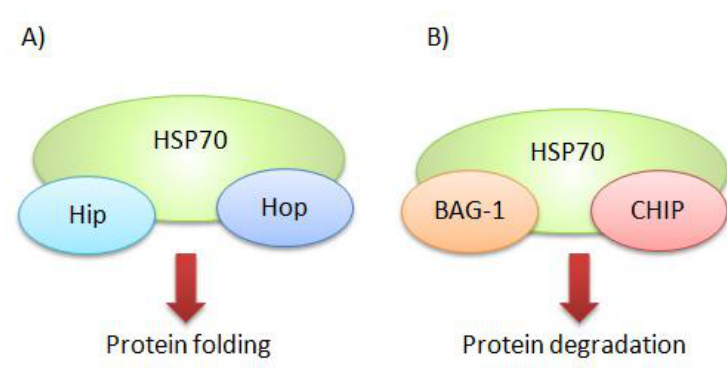
FIGURE 1. Folding vs. degradation. (A) The HSP70 chaperone folding complex is formed upon association with cochaperones such as Hip and Hop. Hip promotes substrate binding, while Hop promotes the recruitment of the HSP90 folding machinery. (B) The HSP70 chaperone degradation complex includes association with BAG-1 and CHIP. BAG-1 competes with Hip for binding to the ATPase domain and favors proteasome recruitment, while CHIP competes with Hop and directs the ubiquitination of chaperoned